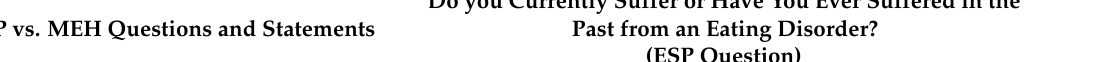
Table 12. The distribution of responses to selected statements from the “My Eating Habits” questionnaire in accordance with behaviors typical for people with anorexia nervosa in